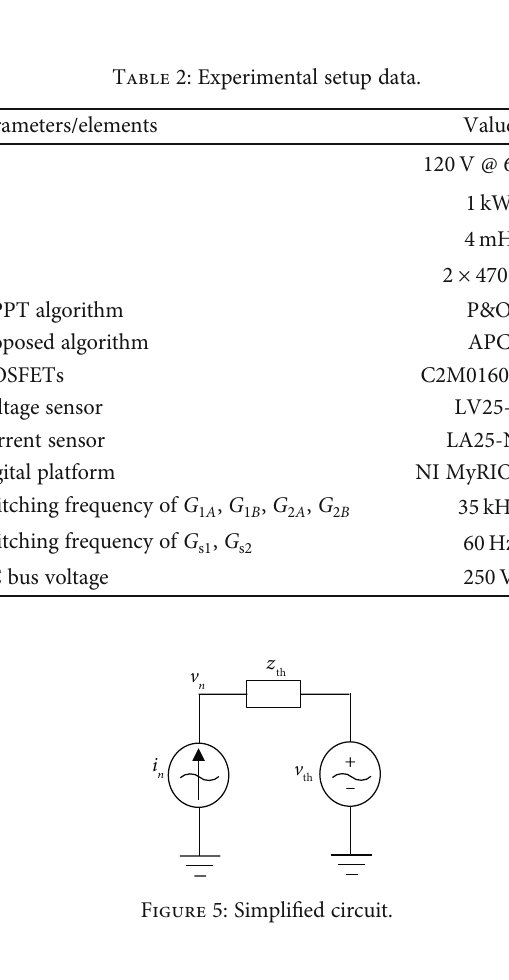
Figure 4: Flowchart: (a) penetration detector; (b) active power controller.